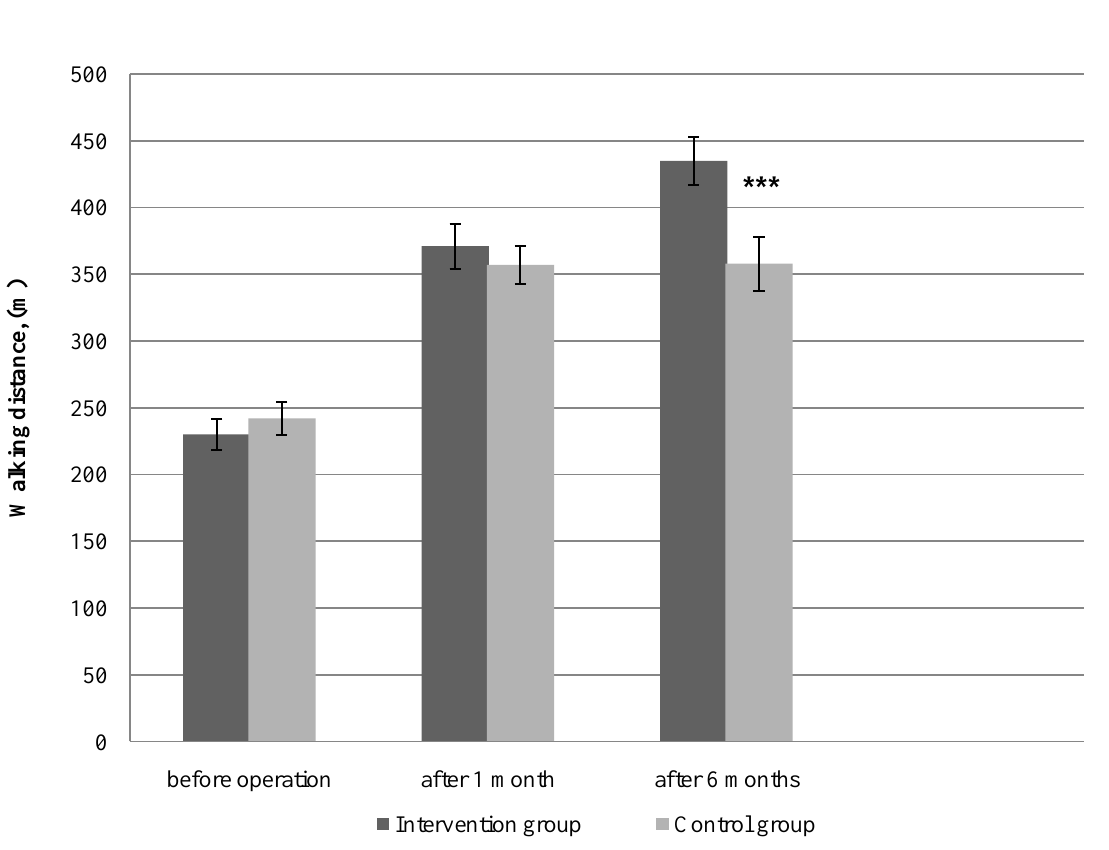
Figure 2. The total six-min walk test measurements at baseline, at 1 and 6 months after the surgery in the intervention (n = 57) and control groups (n =